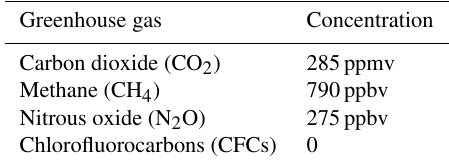
Table 1. Greenhouse-gas concentrations for the ECHAM6 counter- factual